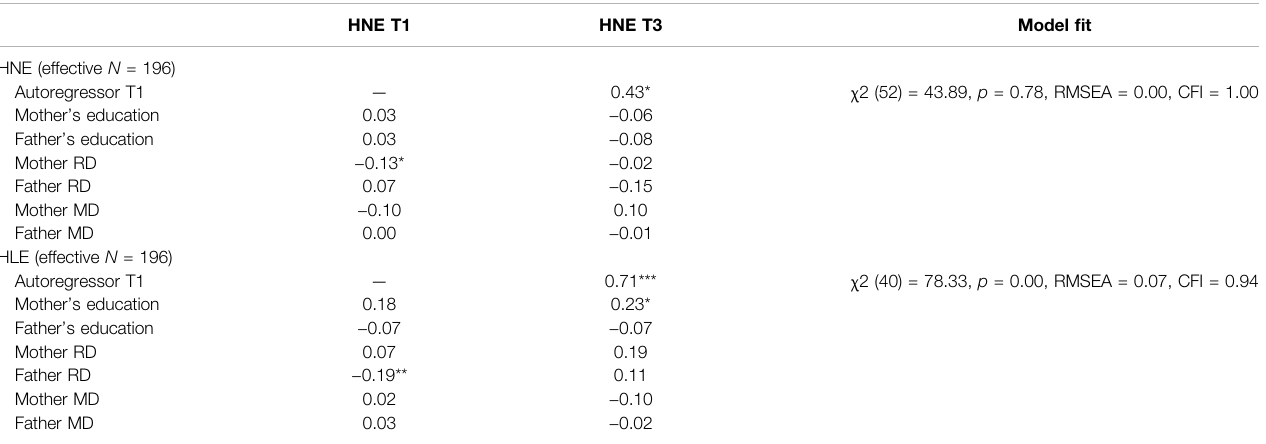
TABLE 4 | The standardized model estimates for parental measures predicting HLE and